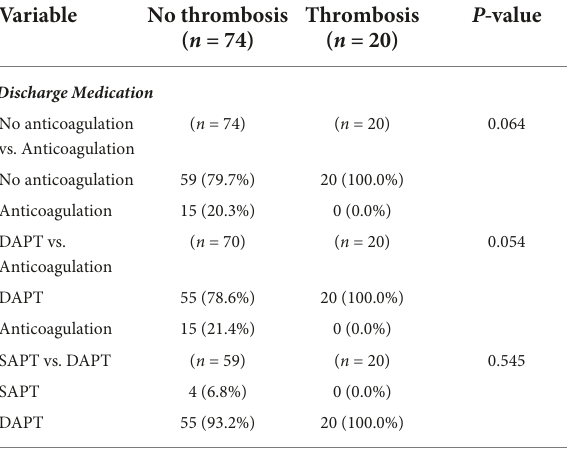
TABLE 3 Prescribed medication comparison between the no leaflet thrombosis and the leaflet thrombosis group.